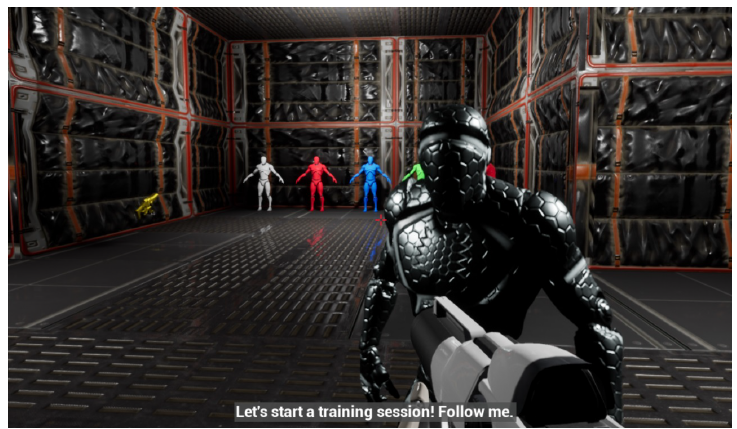
Figure 1. In-game screenshot of the second tutorial